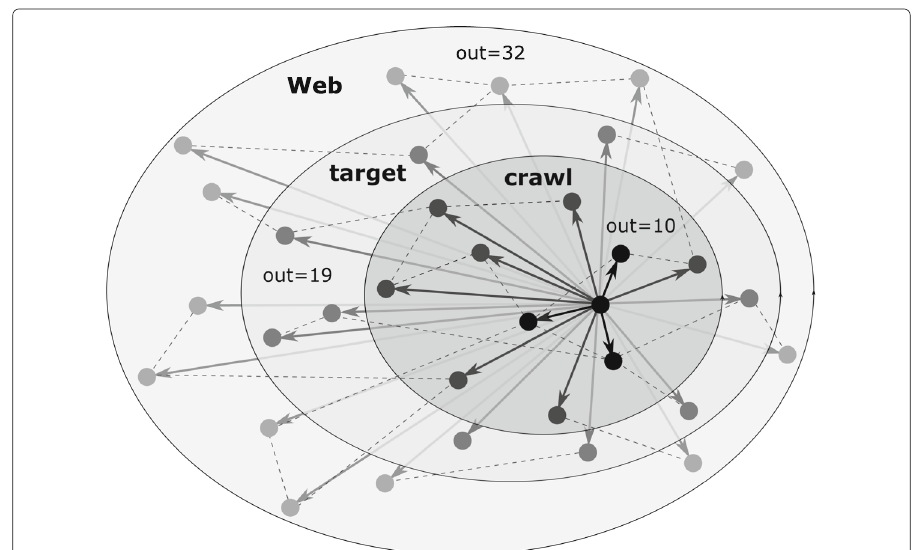
Fig. 1 Neighborhood of a webpage in different subgraphs of the Web